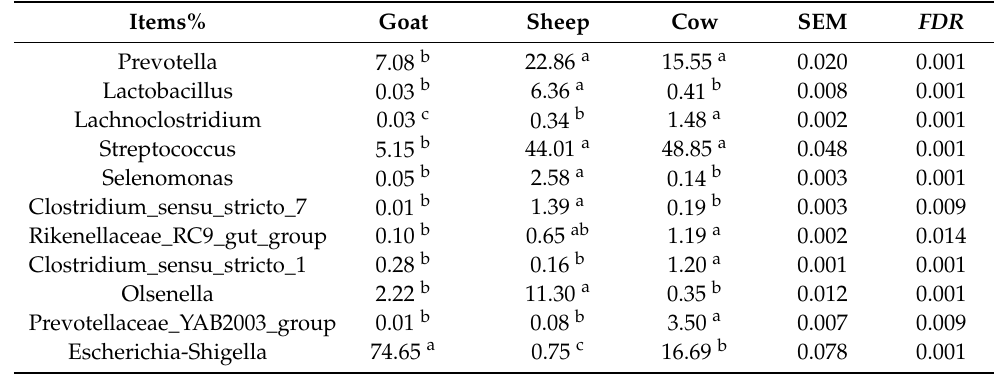
Table 6. Comparison of the bacterial composition between goat, sheep, and cow at the genus level. Items% Goat Sheep Cow SEM FDR